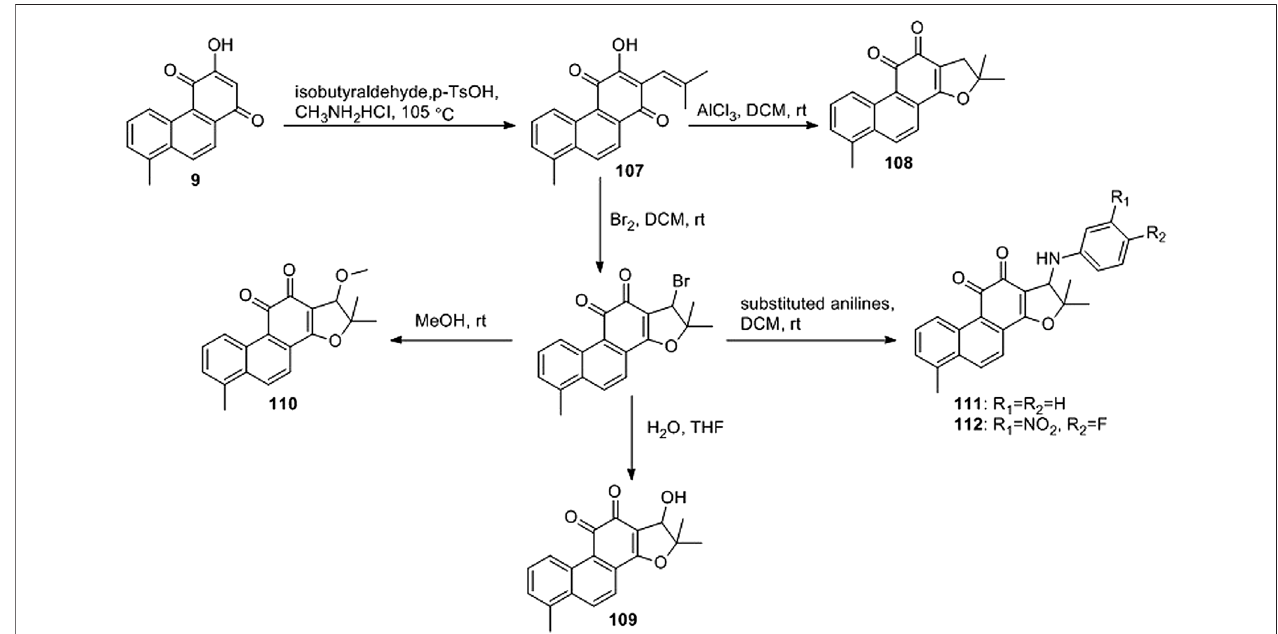
FIGURE 13 | Furan ring dearomatization.